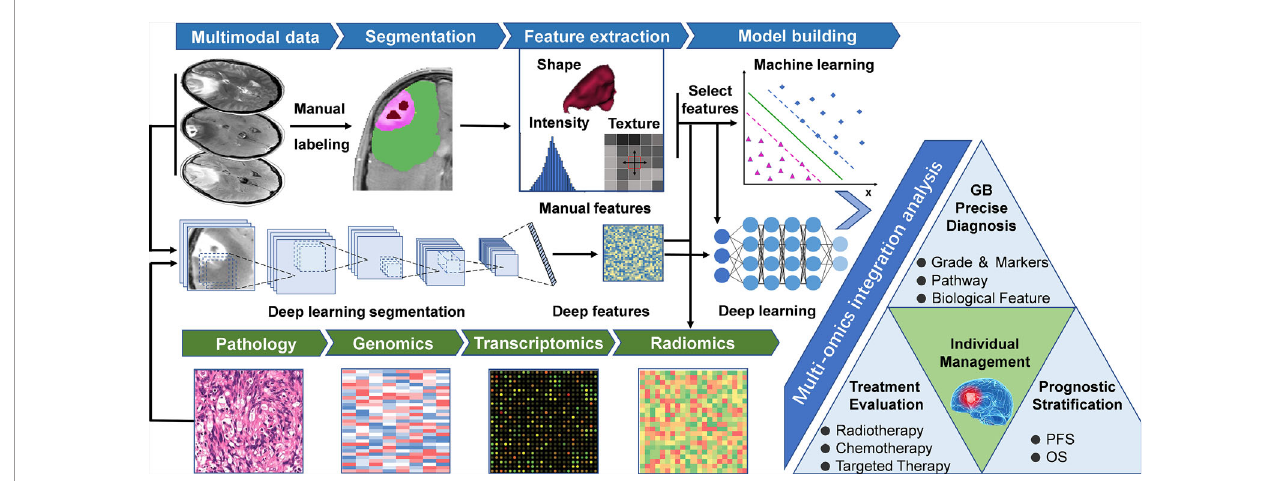
FIGURE 1 | General work fl ow of radiomics studies in neuro-oncology. The work fl ow of a radiomics study, including the following steps: (1) Multimodal imaging and biological data acquisition; (2) Data preprocessing and standardization; (3) Delineation of regions of interest, including manual segmentation and deep learning-based segmentation; (4) Radiomics feature extraction using prede fi ned algorithms or deep learning techniques; (5) Data analysis, feature reduction, and/or selection for further analysis of machine learning and/or deep neural networks; (6) Multi-omics and clinical information integrated model training and testing, guiding individualized disease diagnosis, treatment evaluation, and prognosis prediction. GB, Glioblastoma; OS, Overall Survival; PFS, Progression free